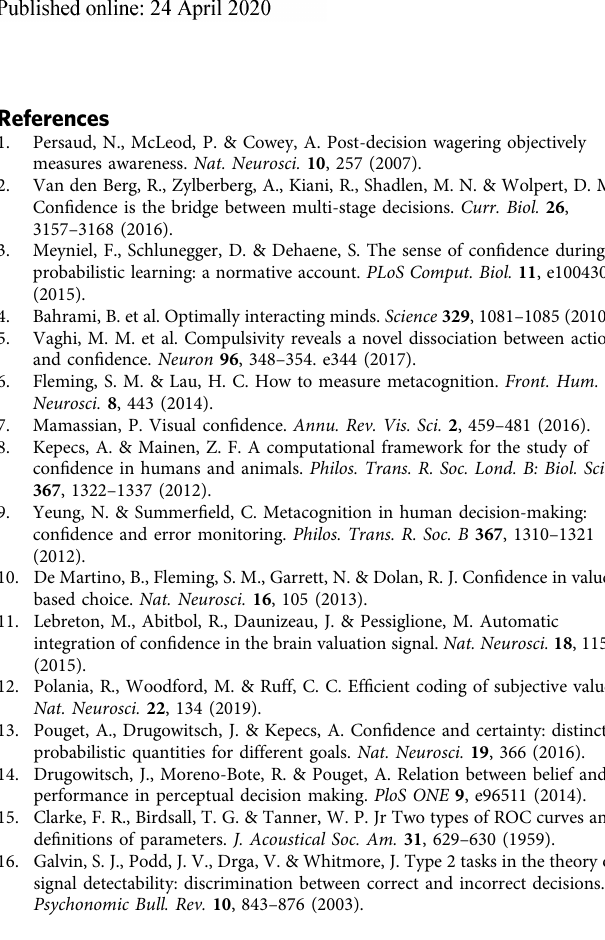
(Fig. 3b, Supplementary Figs. 2, 7, 9 and 11). For Experiment 1, we visualized the data ranging from − 3.5° to + 3.5° from the screen center. For Experiment 3, we visualized the data ranging from − 5° to + 5° from the center. These ranges were chosen so that each steps along the curves in Fig. 3b, Supplementary Figs. 2, 7, 9 and 11 contained at least fi ve trials per subject on average. To visualize the model fi t, we sampled a series of evenly spaced target dot locations along the horizontal axis (in a step of 0.1°), and we used the best- fi tting parameters to compute the con fi dence reports predicted by the models for each target location. We then used the same procedure (a sliding window) to compute the mean con fi dence rating predicted by the models (the model- fi t curves in Fig. 3b, Supplementary Figs. 2, 7, 9 and 11). For Experiment 2, the “ psychometric curve ” became a heat map in a two- dimensional space (Fig. 5). We tiled the two-dimensional space with non- overlapped hexagonal spatial windows (with a radius of 0.25°) positioned from − 3° to + 3° (Fig. 5a) along both horizontal and vertical axis. To compute the mean con fi dence rating for each hexagonal window, we averaged the con fi dence ratings across all the trials fell within that window for each participant. If the number of trials was zero among all the participants for a window, that window was left as white in Fig. 5a. To visualize the model fi t, we used the best- fi tting parameters and computed the con fi dence reports predicted by the models for an array of target locations (a grid tiling the two-dimensional space with a step of 0.1° along both horizontal and vertical axis). The predicted con fi dence reports were then averaged within each hexagonal